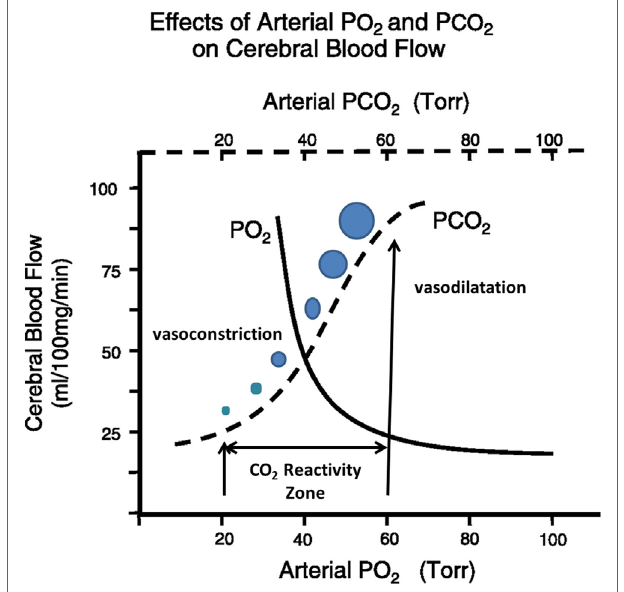
FiGURe 2 | The effects of arterial CO 2 on cerebral blood